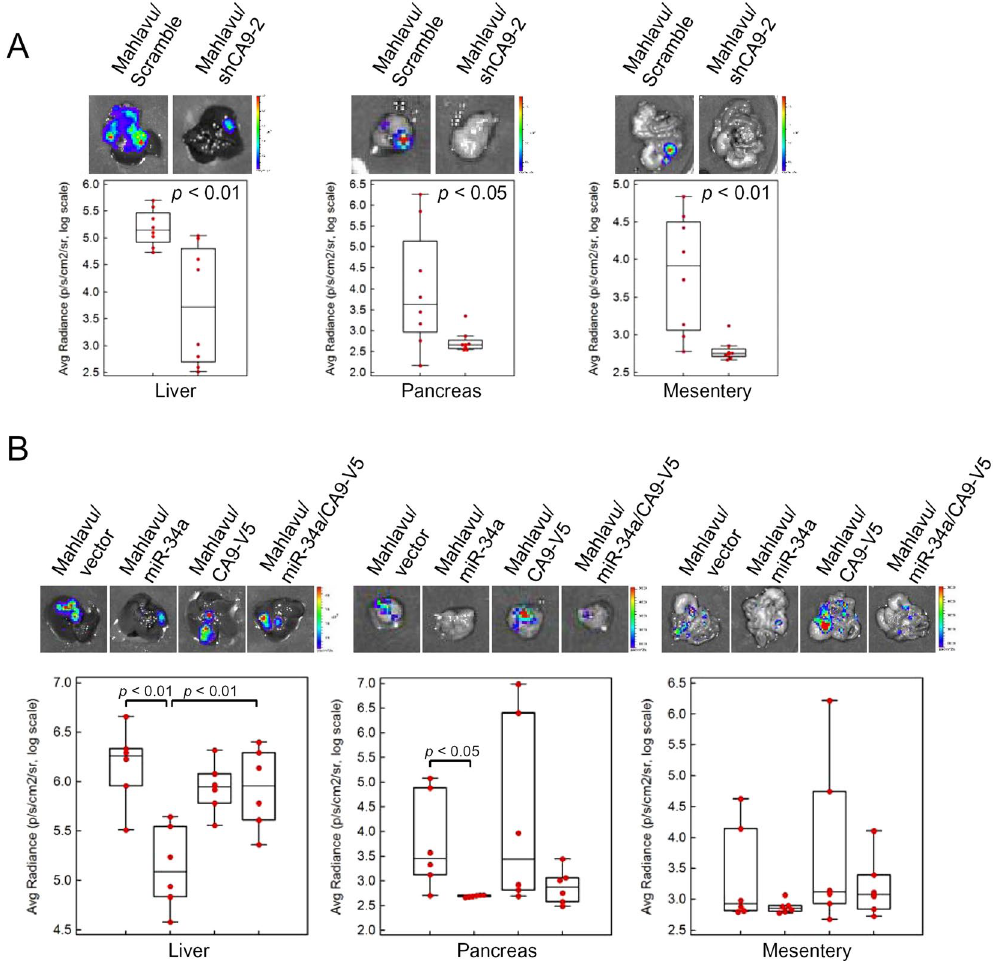
Figure 4. The miR-34a/CA9 axis regulates metastasis of hepatocellular carcinoma (HCC) in vivo . Mahlavu/Luc cells (10 6 ) stably expressing CA9 shRNA-2 or miR-34a were orthotopically injected into NOD/SCID mice for 5 weeks. The tumor burden in the liver and metastases to the pancreas or mesenteries were estimated by luciferase activities. Representative photon images of the liver, pancreas, or mesentery were taken after sacrifice. ( A ) The tumor burden in the liver and metastases of CA9-knockdown cells. ( B ) The tumor burden in the liver and metastases of miR-34a- and/or CA9-V5 overexpressing cells. Statistical significance was assayed by two-sided Student’s t-test. p values are labeled in the